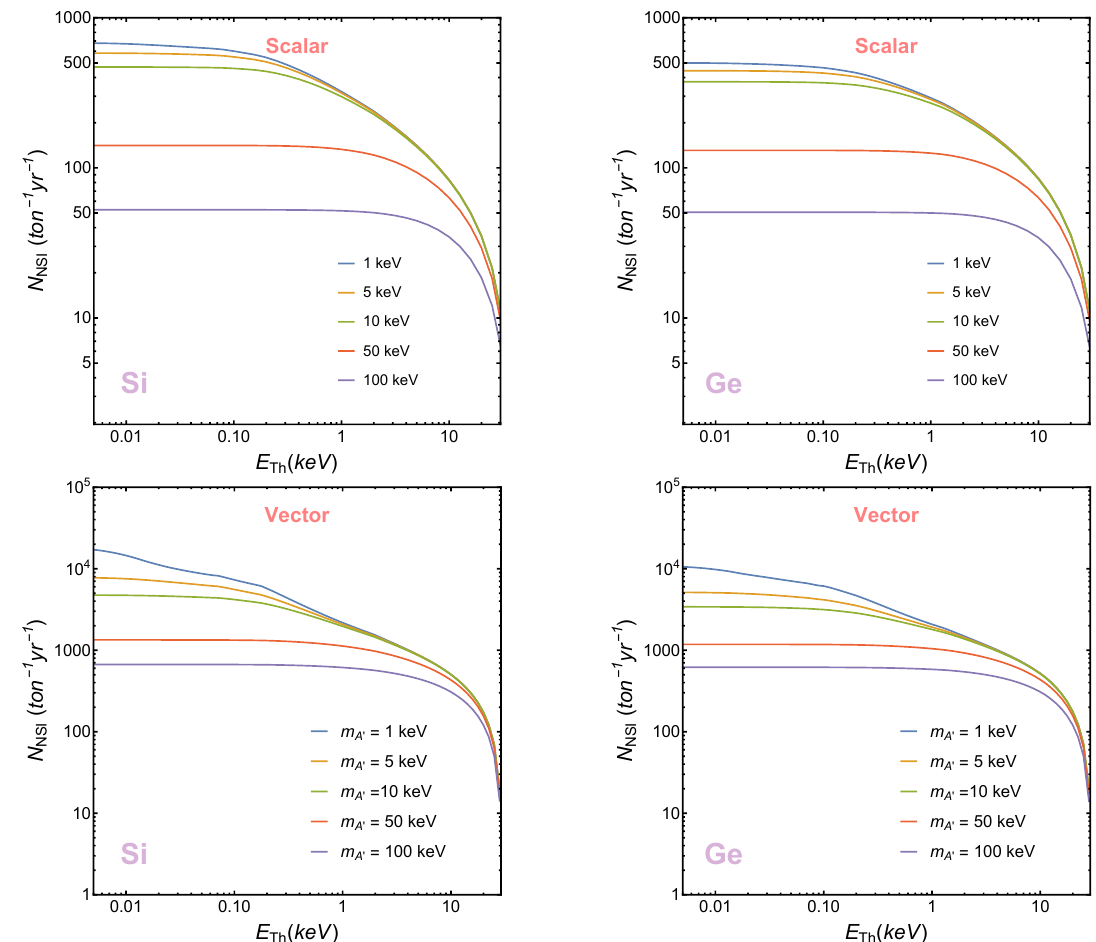
Figure 4 . New physics contribution to the integrated yield of electron recoil events (per ton per year) captured by silicon and germanium detectors as a function of detector threshold E curves are obtained by integrating the rate spectra of figure. 3 from E values are taken as g = g = 5 × 10 − 7 for scalar mediator (Top Panel), and g ν e for vector mediator (Bottom